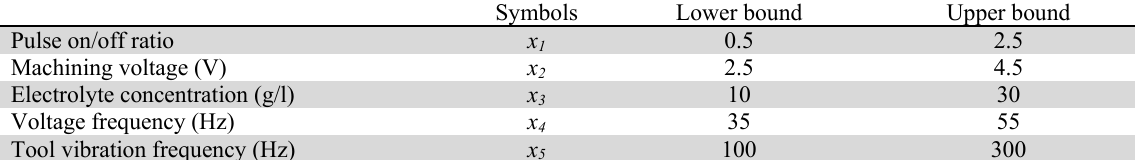
Process factors and their bounds for EMM (Munda and Bhattacharya, 2006)